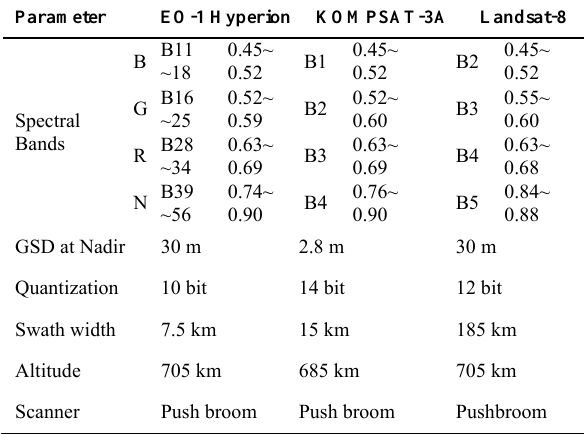
Table 1. lists the key specifications of the KOMPSAT-3A AEISS-A, Landsat-8 OLI, and the EO-1 Hyperion sensor. Only the four bands that the three sensors have in common, as listed in the table. for clarity the bands considered in this paper are named Blue, Green, Red, and Near Infrared (NIR).